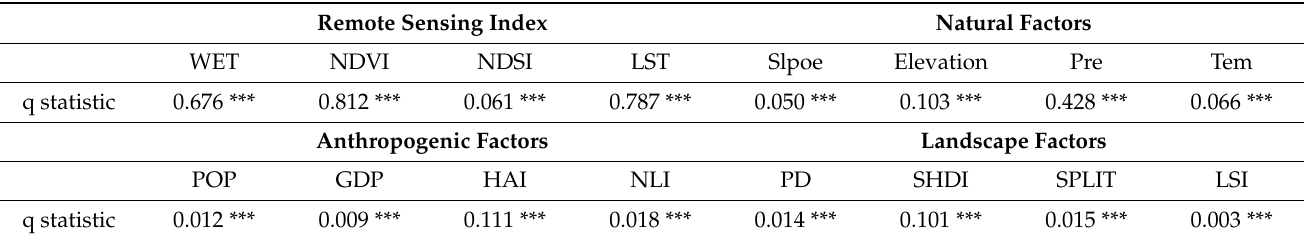
Table 7. Analysis of the results of the influencing factor detection.